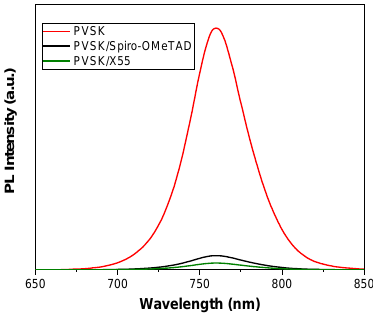
Figure 4. Perovskite layer and perovskite/HTL photoluminescence. The recombinations reduction can be well explained by analyzing the energy level alignment between the perovskite and the HTL. The HOMO energy levels of X55 and Spiro-OMeTAD are 5.23 and 5.13 eV, respectively [17,28]. In this condition and